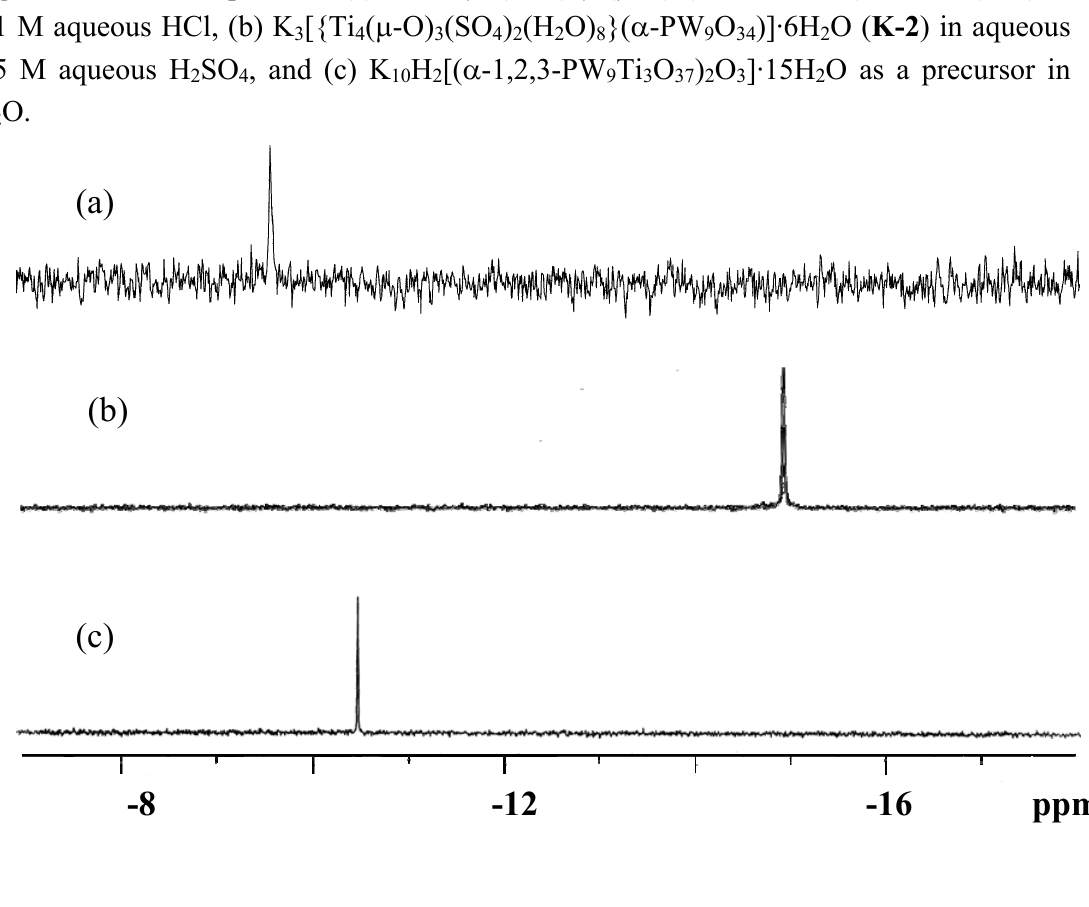
Figure 4. Solid-state 31 P-CPMAS NMR spectra of (a) K PW Ti O )] ·9H O ( K-1 ), (b) K 9 2 38 2 2